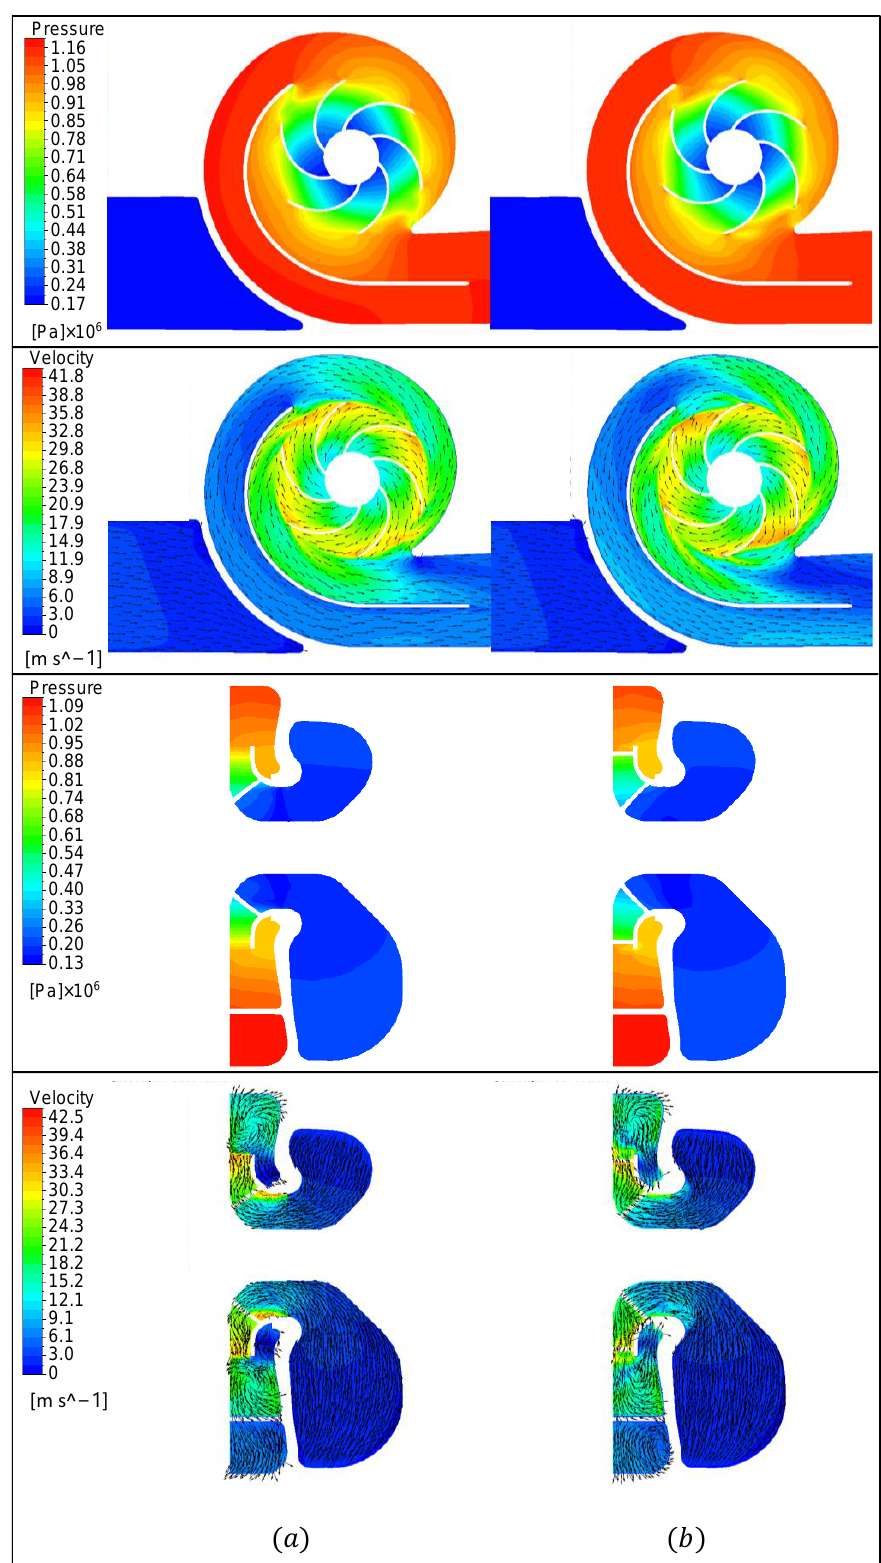
Figure 11. Pressure and velocity contour plots at rated flow for ( a ) the model with Poly-Hexcore Mesh and ( b ) the model with multi-block structured hexagonal mesh.